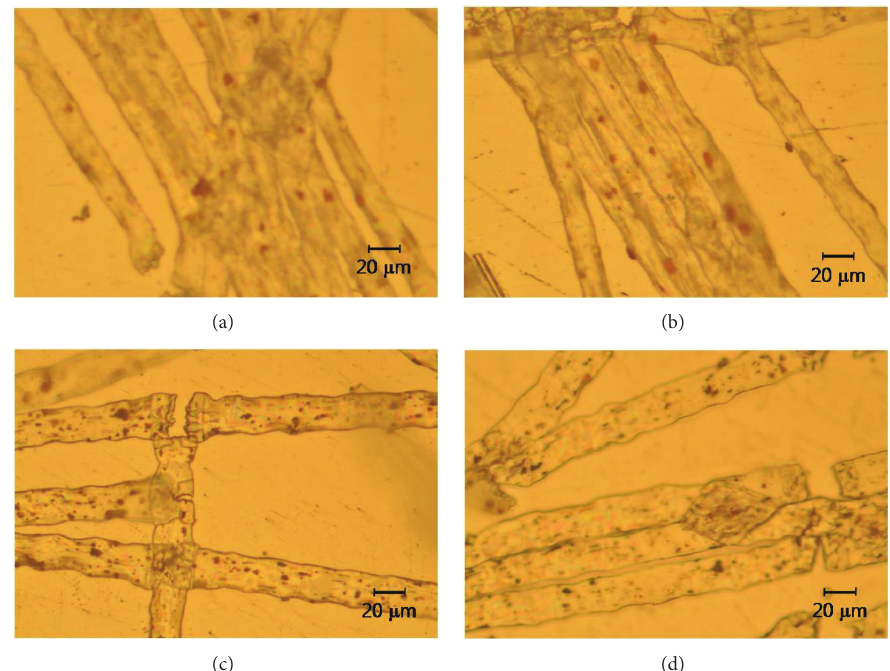
Figure 7: Optical micrographs ( × 400) of the spun fiber with cellulose particles at various heat treatment conditions. (a) Cel 30 particles. (b) Cel 35 particles. (c) Cel 40 particles. (d) Cel 40/120 particles.